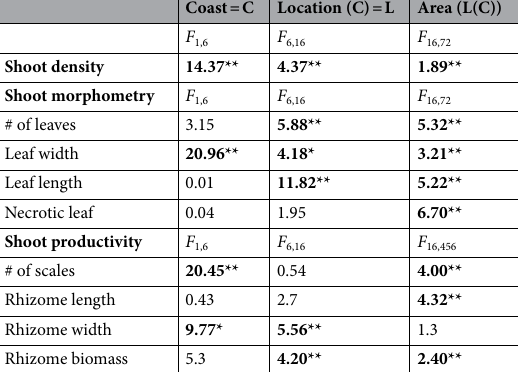
Table 1. ANOVAs: effects of coast (west vs east), location (4 levels), and area (3 levels) on Posidonia oceanica shoot density, morphometry (# of leaves, leaf width, leaf length, necrotic leaf) and productivity (# of scales, rhizome length) variables. For each ANOVA, the F values are given. In bold are the significant values (* for p -value significance level 0.01, ** for p -value significance level